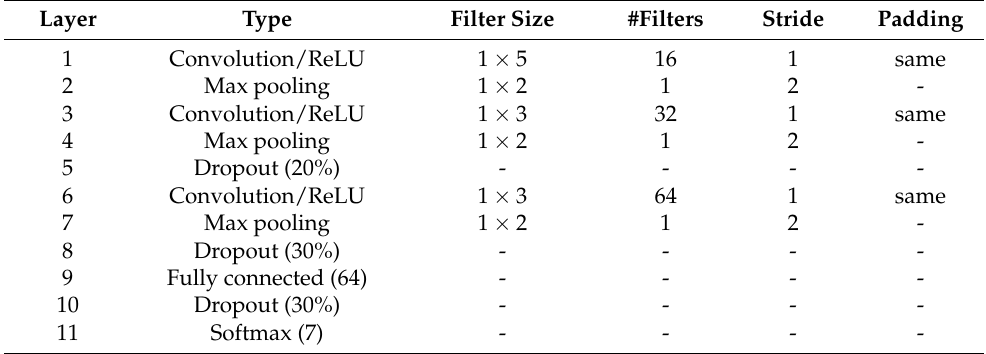
Table 2. The 1D CNN architecture.